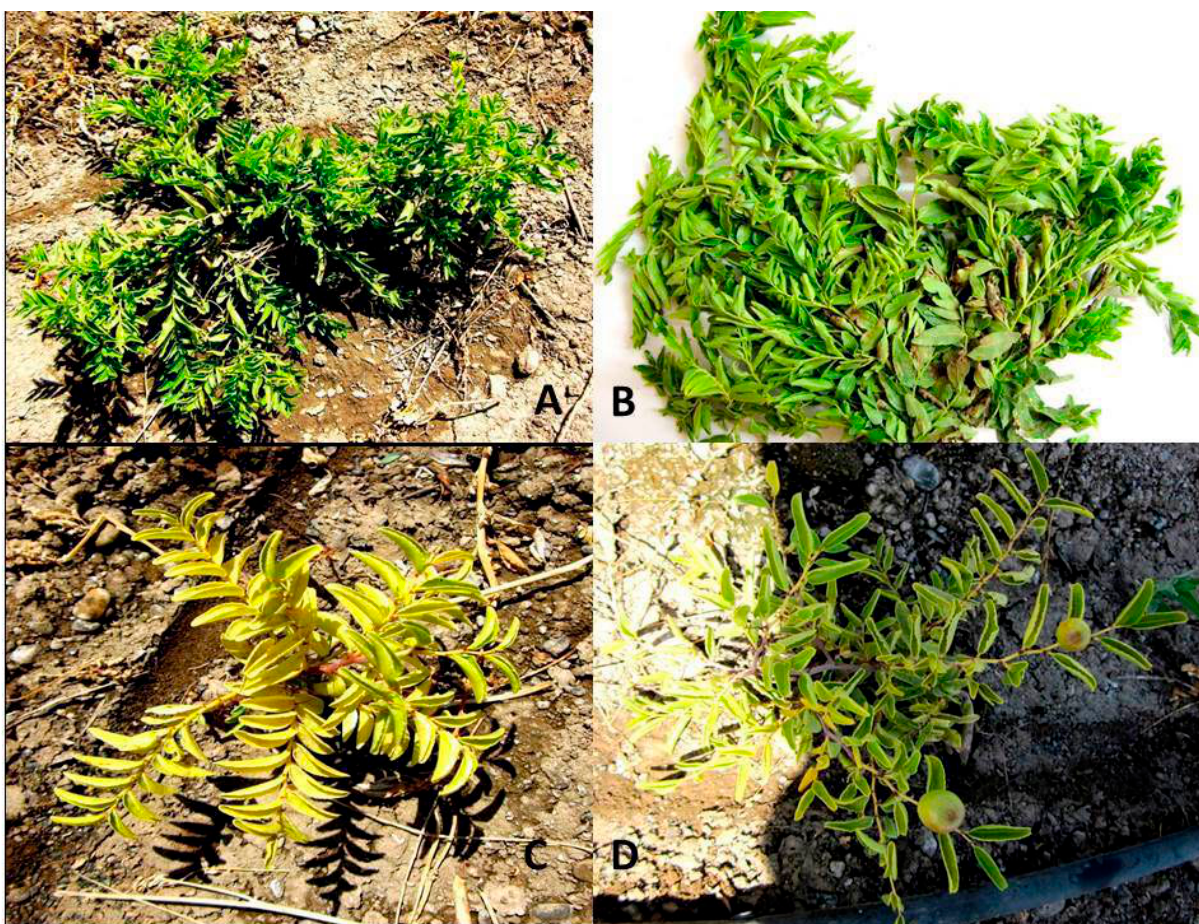
Figure 1. Phytoplasma disease symptoms on jujube plants: (A) and (B) proliferation and witches’ broom, (B) and (C), (D) yellowing, leaf rolling and stunting of an infected